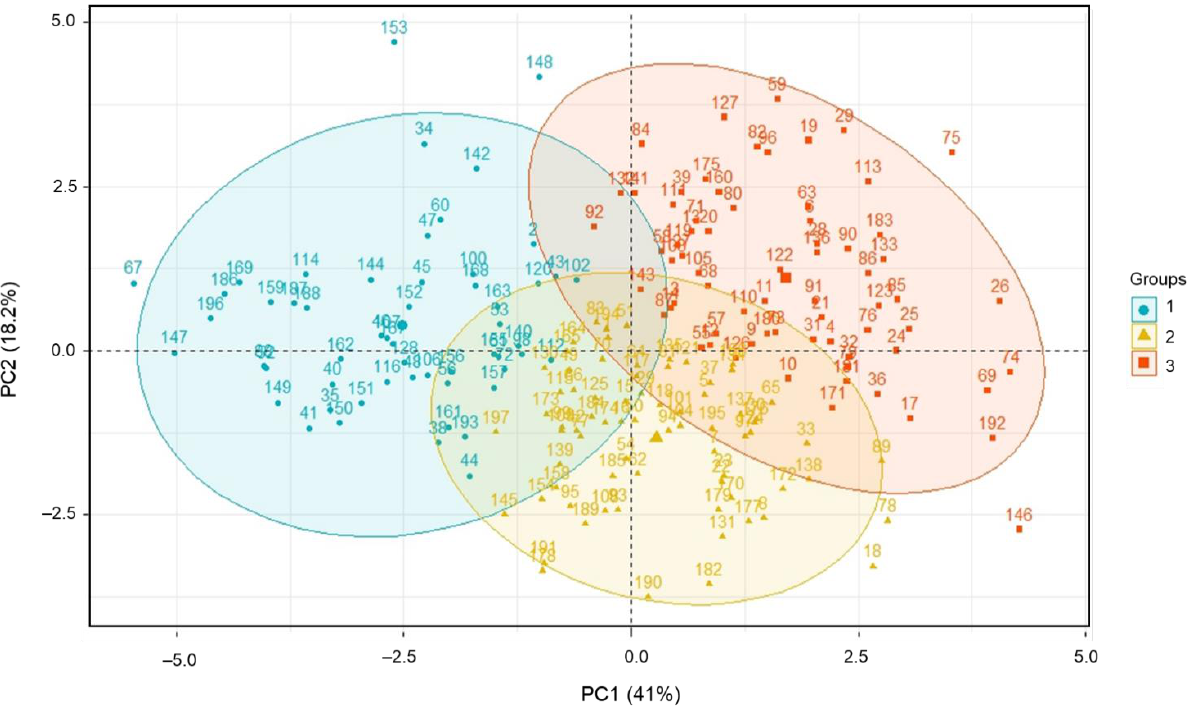
Figure 3. Hierarchical clustering principal component analysis biplot showing safflower genetic re- source clustering based on total oil content, fatty acid profile, phytochemical contents, and antioxidant activities using the entire dataset.